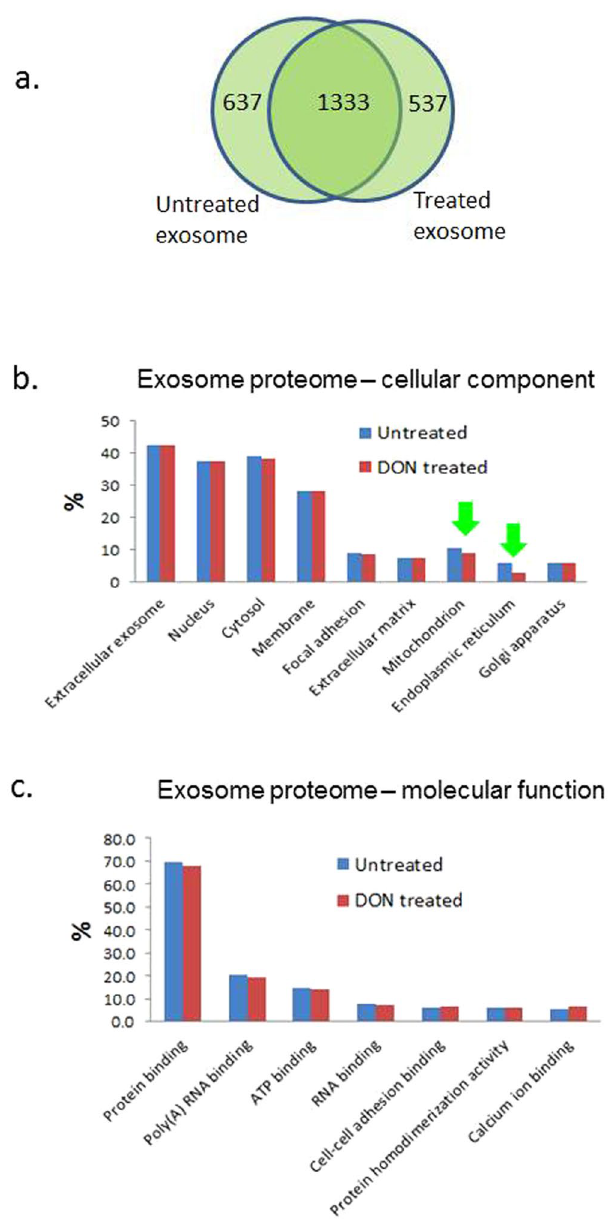
Figure 8. Comparison of protein profiles of exosomes derived from GEM-R MiaPaCa pancreatic cancer cells with and without DON treatment. ( a ) Comparison of protein identification in exosomes derived from GEM-R MiaPaCa cells with and without DON treatment. ( b ) Comparison of cellular location of proteins identified in exosomes derived from GEM-R MiaPaCa cells with and without DON treatment. ( c ) Comparison of molecular function of proteins identified in exosomes derived from GEM-R MiaPaCa cells with and without DON